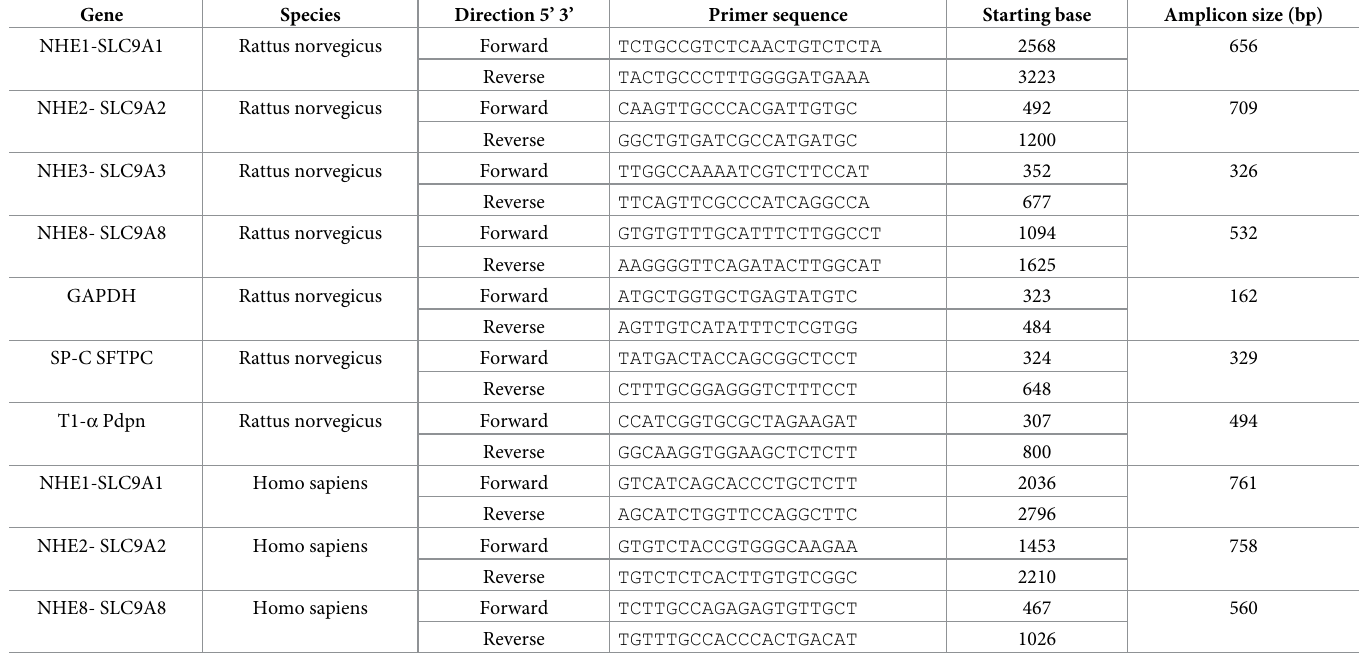
Gene Species Direction 5’ 3’ Primer sequence Starting